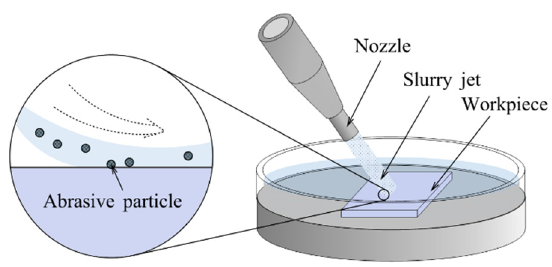
Figure 32. The schematic diagram of FJP [244].